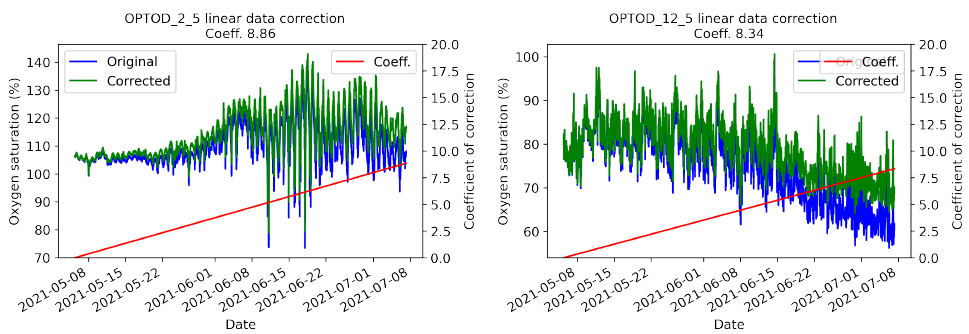
Figure 13. Data correction of time-series collected by the OPTOD sensors by Ponsel one positioned at 2.5 and another at 12.5 m depth.